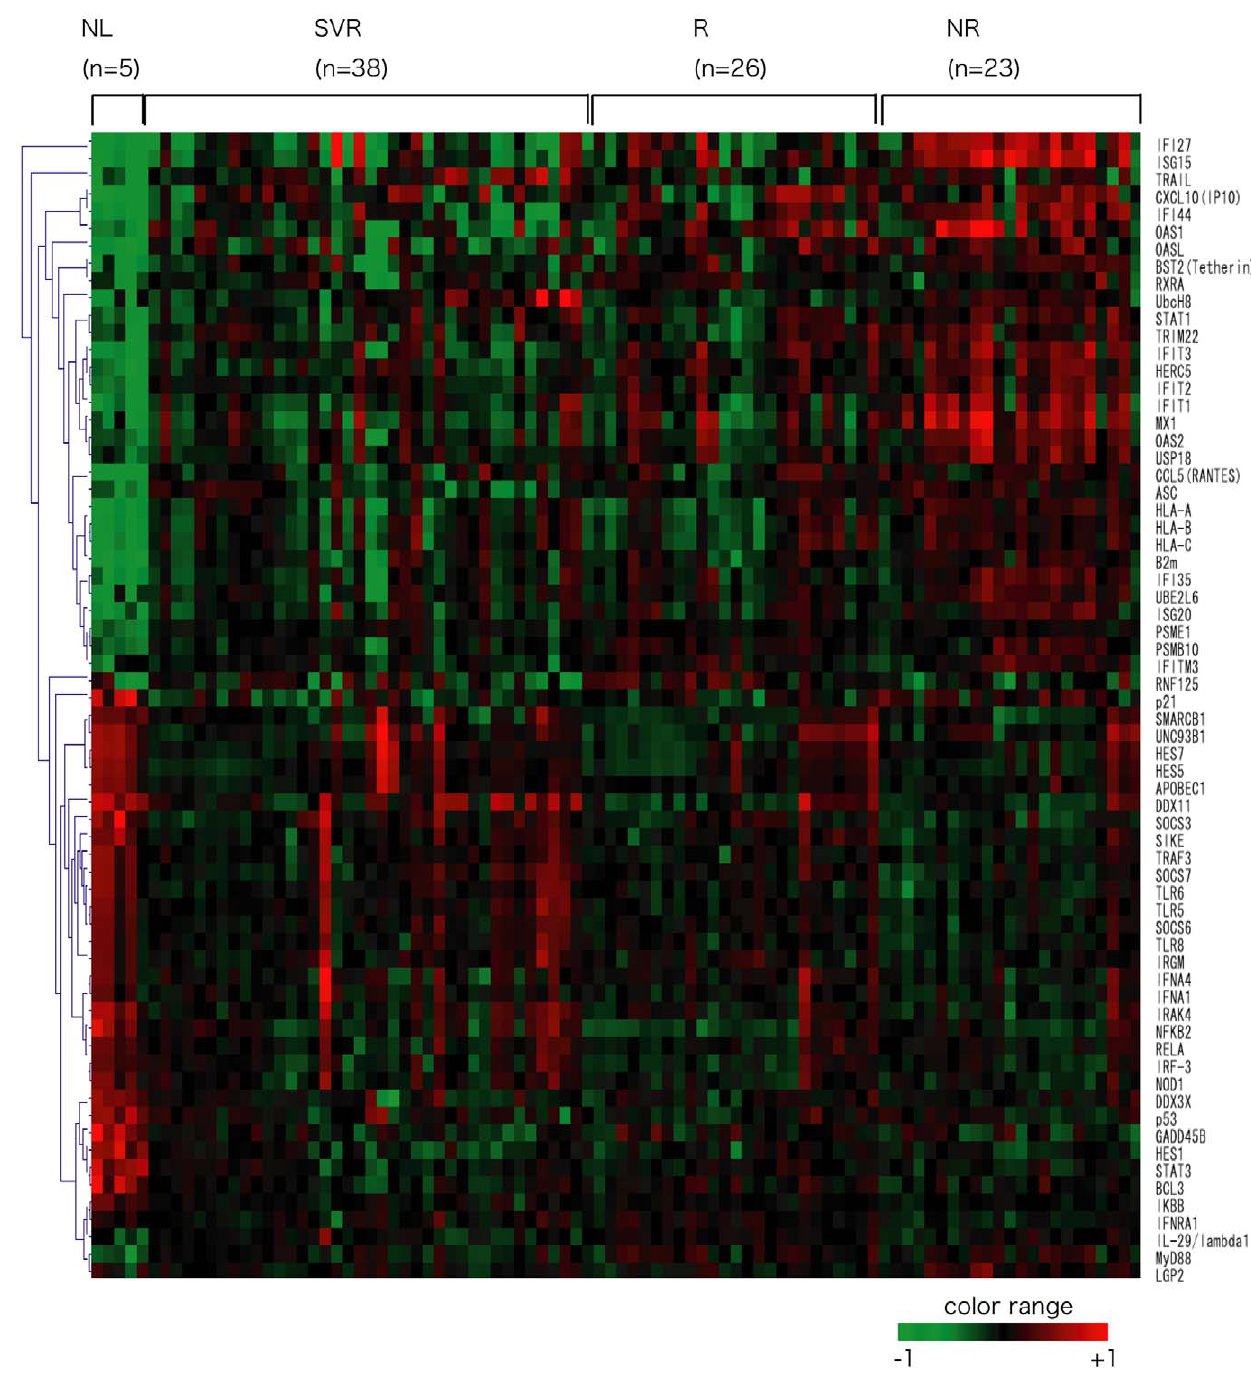
Figure 1. Clustering of IFN related gene expression. Clustering of CH patients according to the expression profiles of the 66 genes that showed significant differences among SVR, R, NR, and NL. Vertical bars represent the IFN related genes and the horizontal bars represent the samples. Green bars reflect down-regulated genes and red bars up-regulated genes.